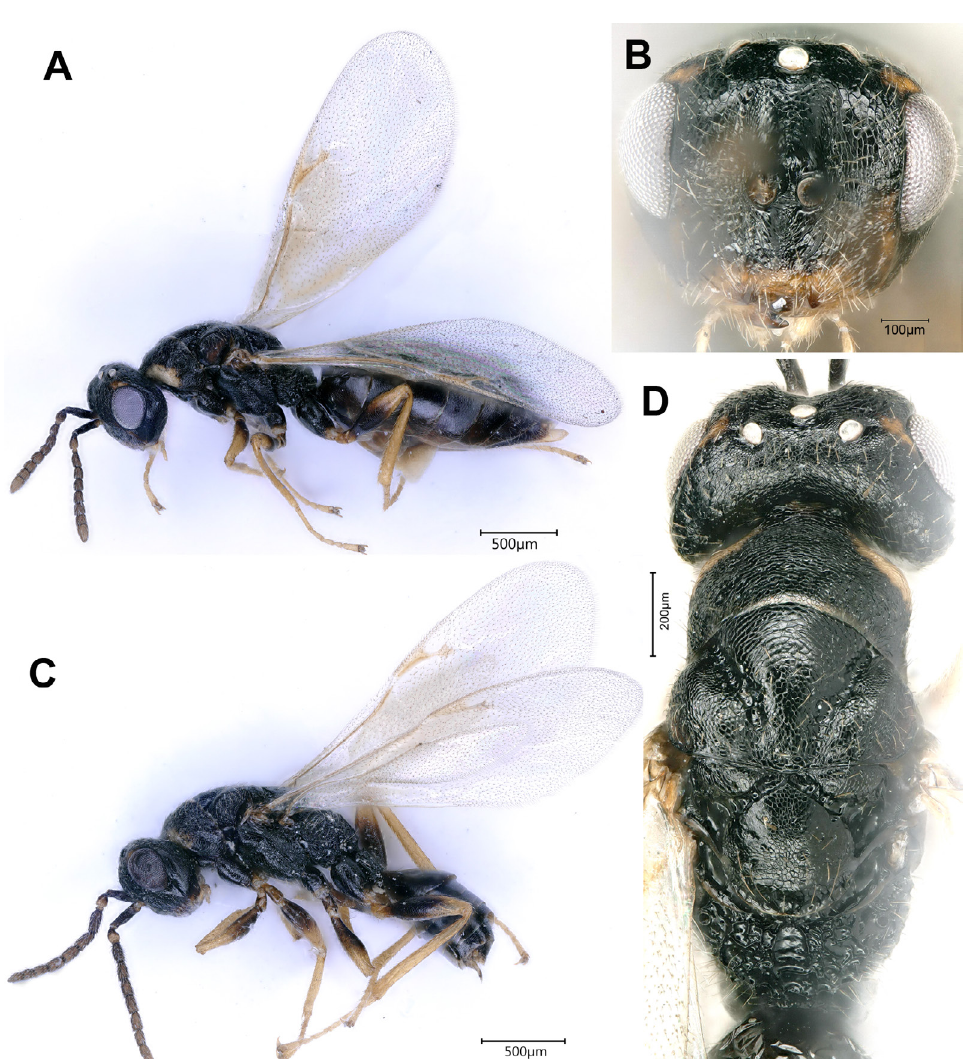
Fig. 10. Tetramesa sp . A . Female in lateral view. B . Head of female in frontal view. C . Male in lateral view. D . Head and mesosoma in dorsal